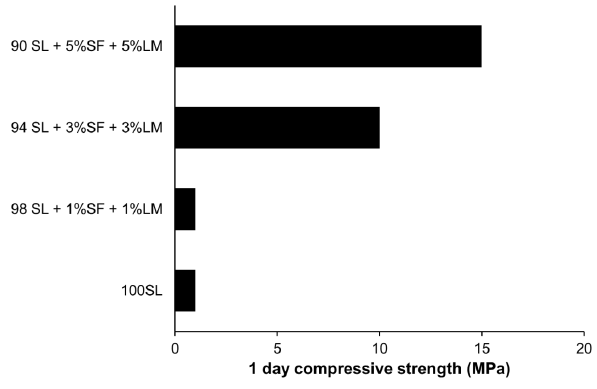
Figure 10: Effect of hybrid additives on 1-day compressive strength (adapted from